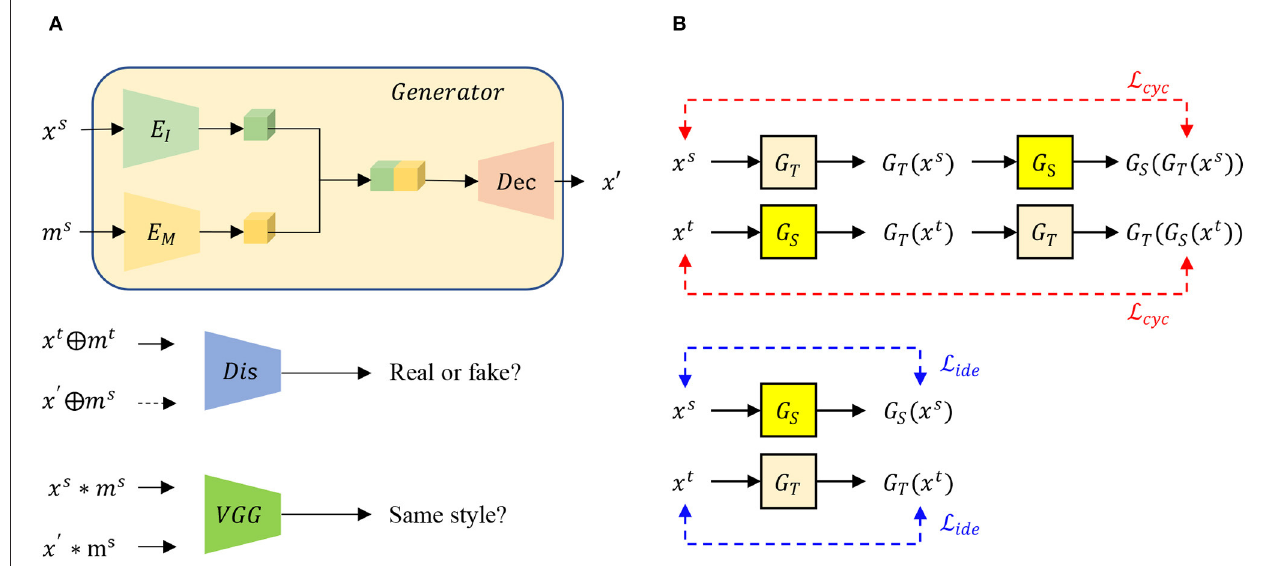
FIGURE 2 | (A) Proposed SCIT model, the general structure of the proposed data augmentation model for image classification, object detection, and instance segmentation. x s and x ′ denote the s ource image and the generated image by our model. While m s denotes instance segmentation mask aligning source image x s and expecting to align x ′ , m t is the instance segmentation mask of real images in the target domain. The generator consists of an image encoder E I , a mask encoder E M , and a decoder Dec . Discriminator Dis pushes the region of interest (ROI) of the generated image to have the same label with the ROI of the real image in the target domain, while the pre-trained VGG pushes ROIs to share the same style. (B) Flow chart to compute identity loss and cycle-consistent loss. G T and G S is the generator to produce images in the domain T and S , respectively. The masks to generate the image are